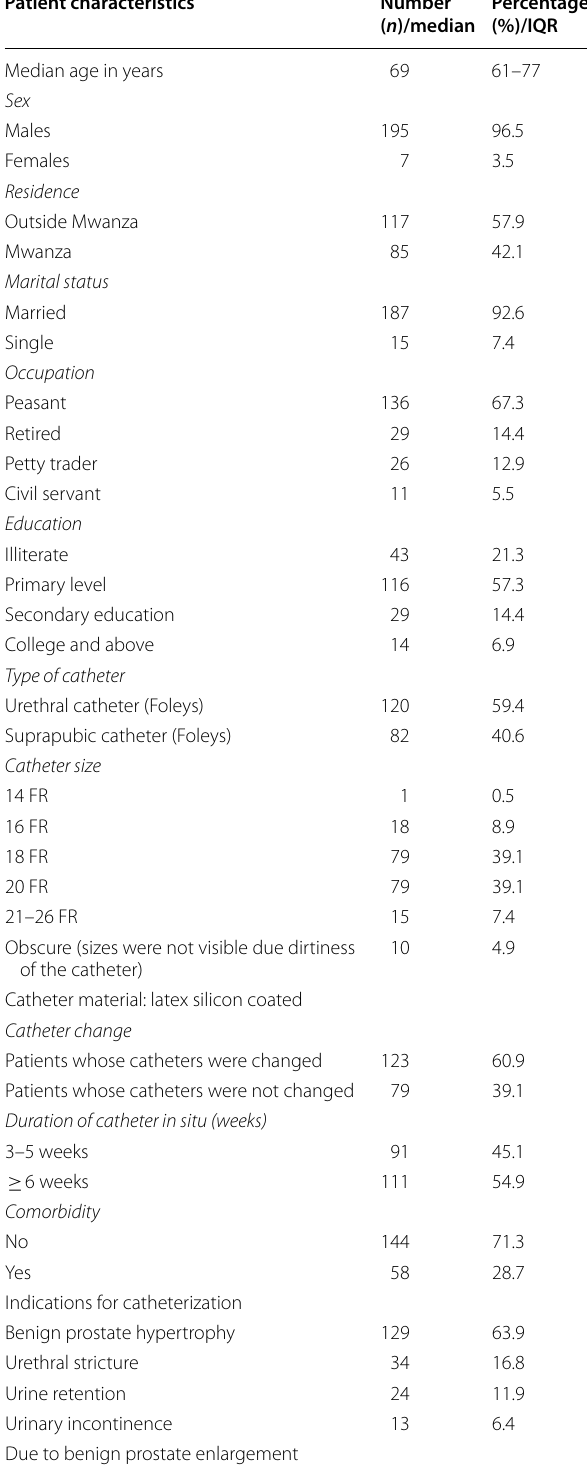
Table 1 Sociodemographic and clinical characteristics of out-patients with long-term indwelling urinary